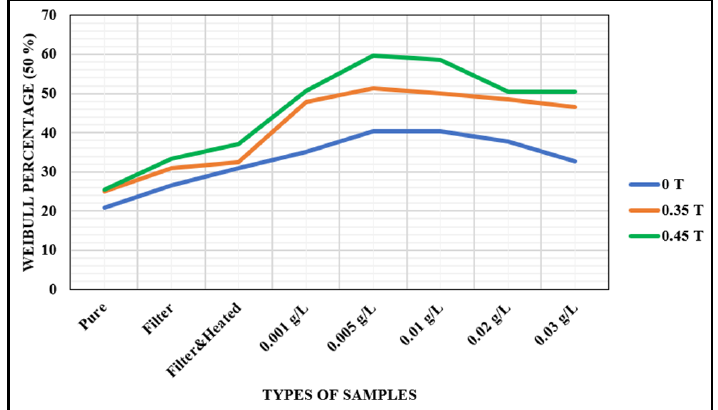
Figure 6. Weibull percentage of 50 % of breakdown voltage.